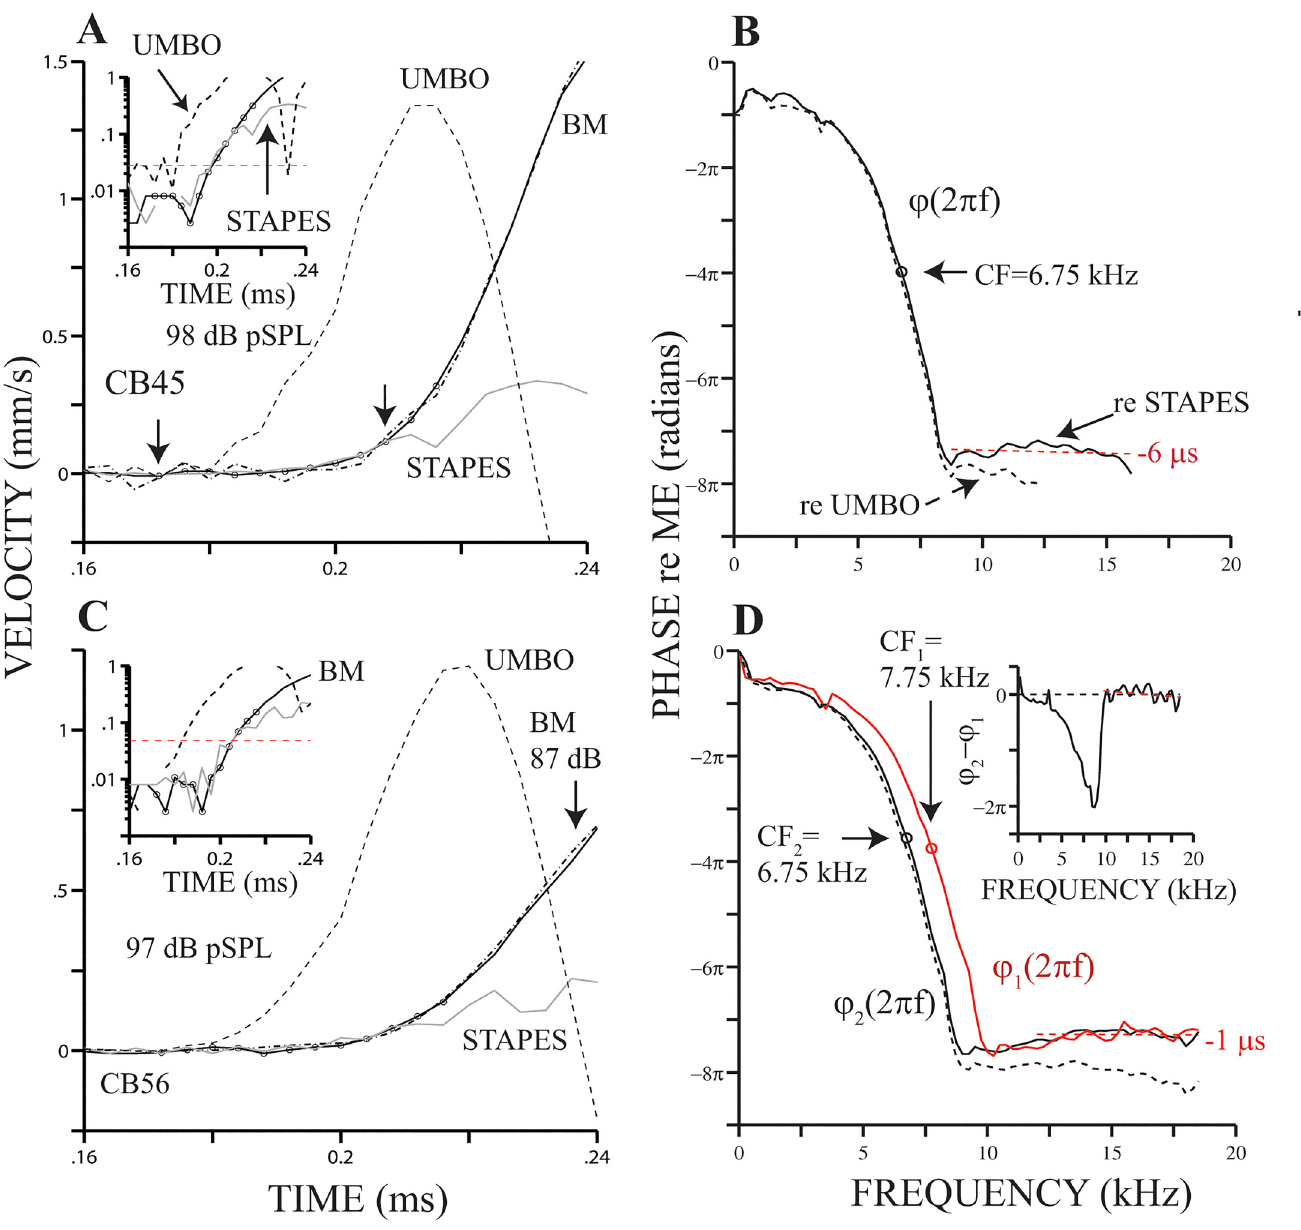
Fig 2. Onsets of stapes and BM responses to clicks are similar. Panels (A) and (C) display umbo, stapes and BM responses to clicks in the animal preparation indicated in each panel. Data are expressed in velocity units and BM responses are shown inverted. Stapes responses (gray lines) have been delayed by 4 μ s. Continuous black lines with circles represent BM click response at the maximum possible level, as indicated in each panel. Dotted dashed lines display BM responses to clicks at the maximum level minus 10 dB. Insets in (A) and (B) display absolute values of stapes and BM responses in semi- logarithmic coordinates. Circles in the insets represent the so-called initial segment (see text). Black lines in (B) and (D) display phase-vs.-frequency curves, φ (2 π f ), of the responses in (A) and (C), respectively. Red trace in (D) represents a φ (2 π f ) measured from responses at another BM location in the same animal. Inset in (D) displays a local phase-vs.-frequency function equal to φ 2 (2 π f ) − φ 1 (2 π f )